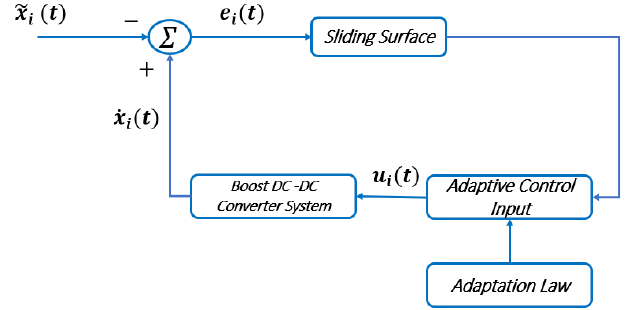
Figure 2. Block diagram of the ACTSMC system.